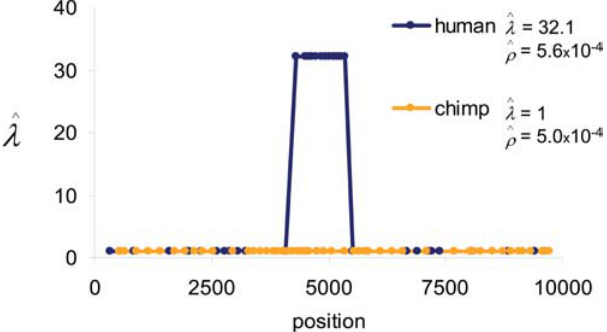
Figure 2. Estimates of the Recombination Hotspot Intensity, k , Based on Genotype Data We assumed that, if the hotspot is present, it is in the same location as estimated by sperm typing in humans (see Materials and Methods). A k value of one corresponds to the absence of recombination rate variation, while values of k greater than one indicate a hotspot. The estimates for humans from the UK are shown in blue and those for western chimpanzees in